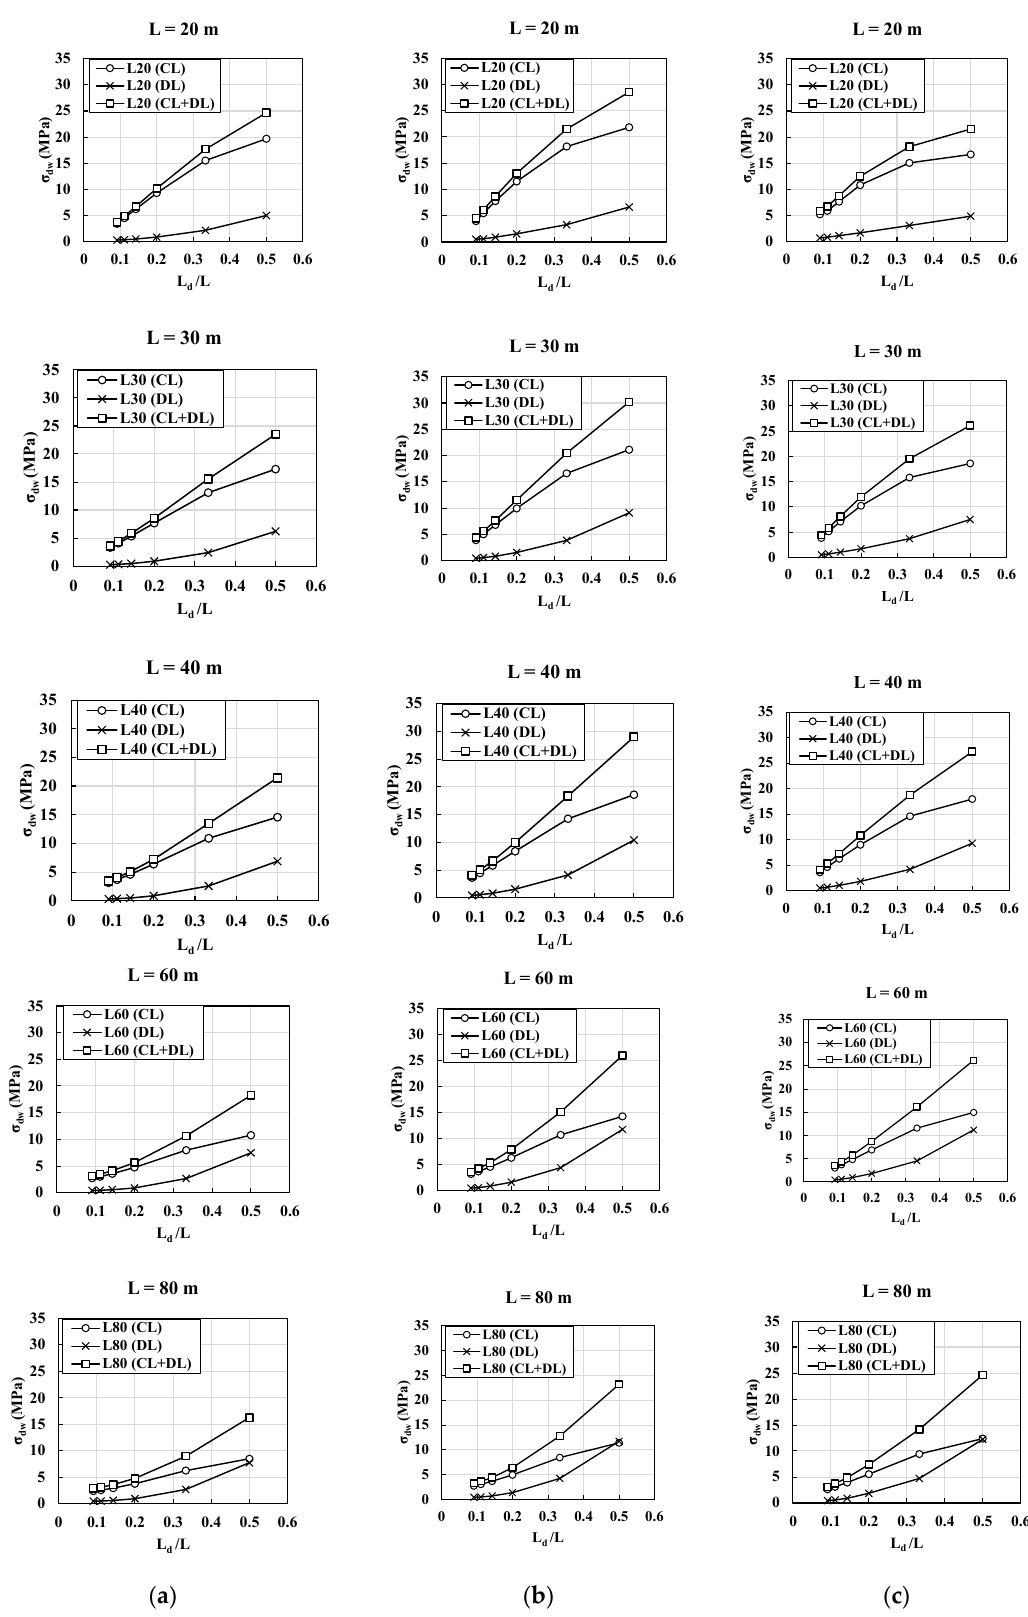
Figure 10. Variations in distortional warping normal stresses with the design load components, 𝐻/𝐵 , and 𝐿 . ( a ) 𝐻/𝐵 = 0.5 , ( b ) 𝐻/𝐵 = 0.7 , and ( c ) 𝐻/𝐵 = 1.0 .